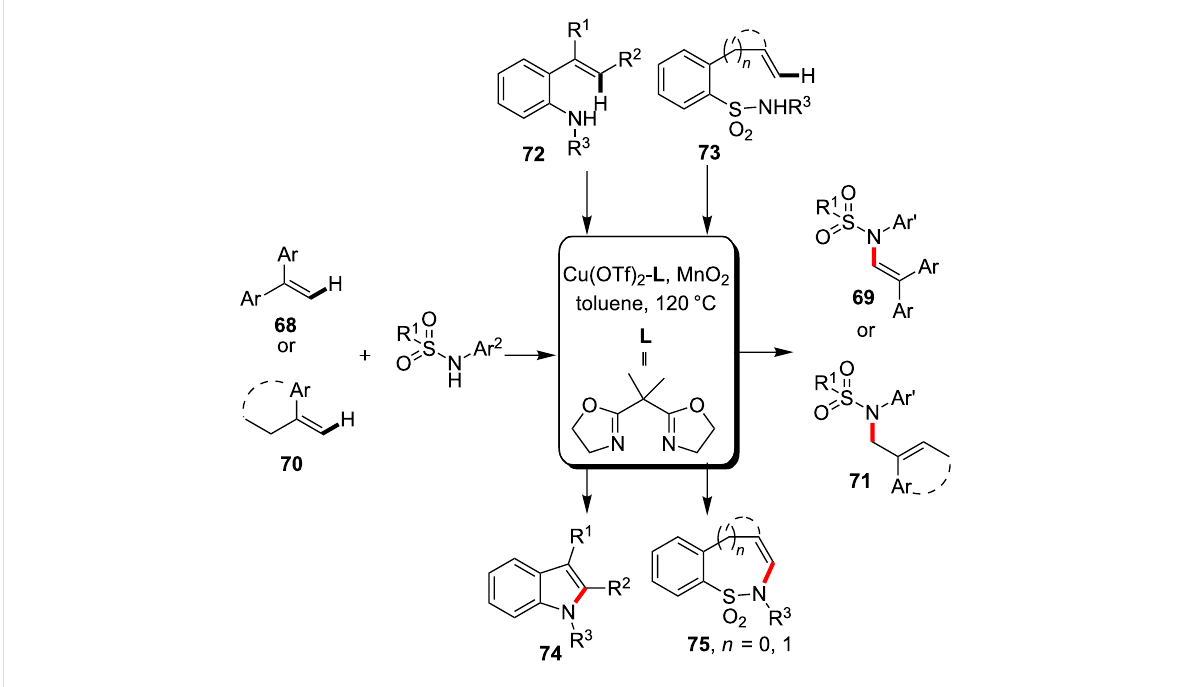
Scheme 18: Copper-catalyzed sulfonamidation of vinyl C–H